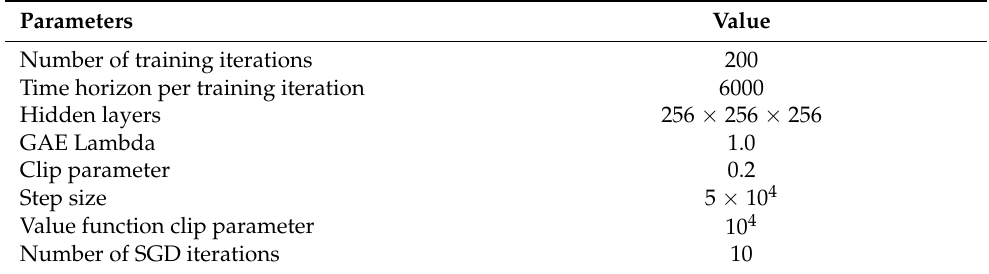
Table 2. A set of clipped PPO hyperparameters for a non-signalized intersection.